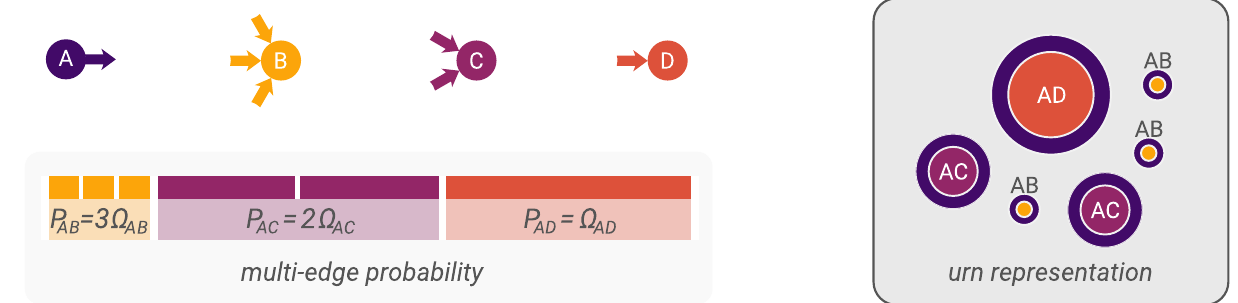
Figure 2. The effect of edge propensities on the configuration model. Differently from the standard configuration model, here the stubs are not sampled uniformly at random (cf. Fig. 1). Given an out-stub, each in-stub is characterized by a propensity (cid:31) ij of being chosen. As a result, the probability of wiring the out-stub ( A , · ) to the vertex D is larger than that of B due to a very large edge propensity (cid:31) AD , even though vertex B has three times more in-stubs than vertex D